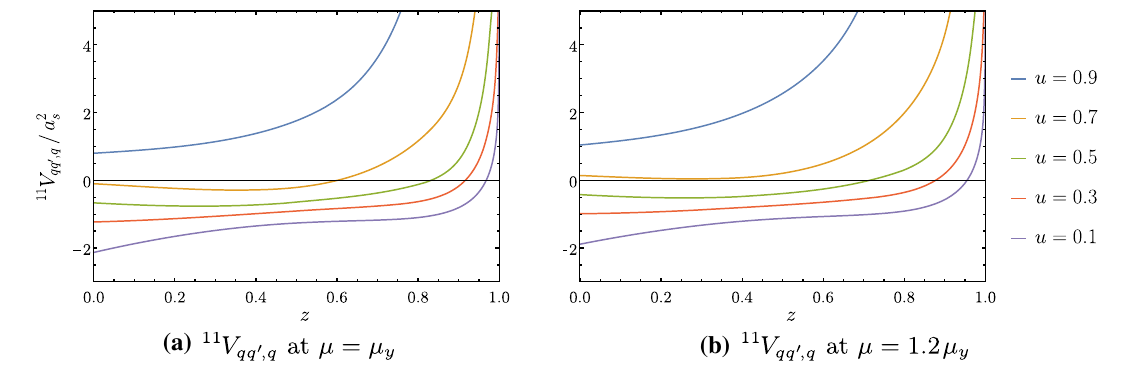
Fig. 6 The kernel 11 V qq (cid:3) , q ( z 1 , z 2 ) , which appears in the DPDs for the parton combinations ud and u ¯ d as specified in (49), (51), and (52). A global factor a 2 s has been divided out. See (47) for the relation between z 1 , z 2 and u , z . The order of curves from top to bottom is identical in the plots and in the legend